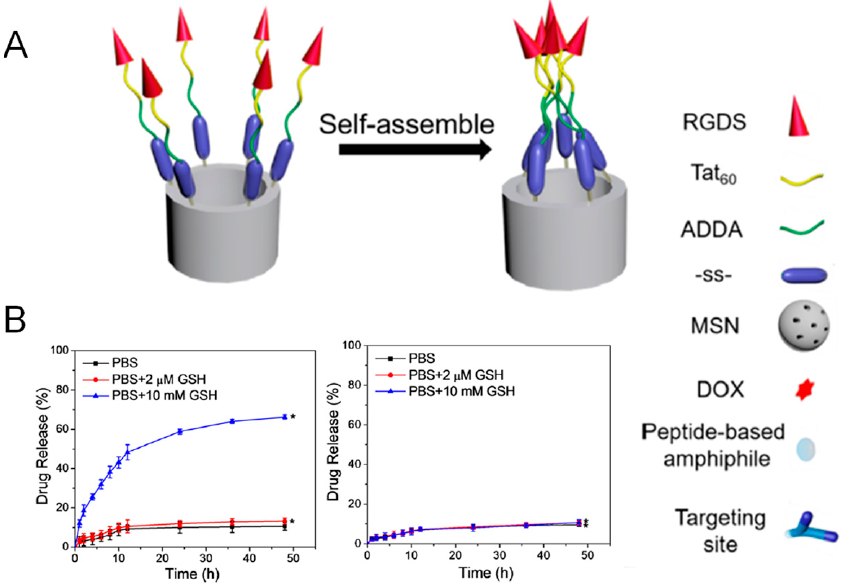
Figure 7. ( A ) Schematic representation of the redox-responsive gatekeeper. ( B ) Release experiment in the presence or absence of biologically relevant levels of GSH. Of note, when a disulfide bond is not employed the drug release does not take place (graph on the right). Reproduced with permission from [45]. Copyright ACS, 2017.